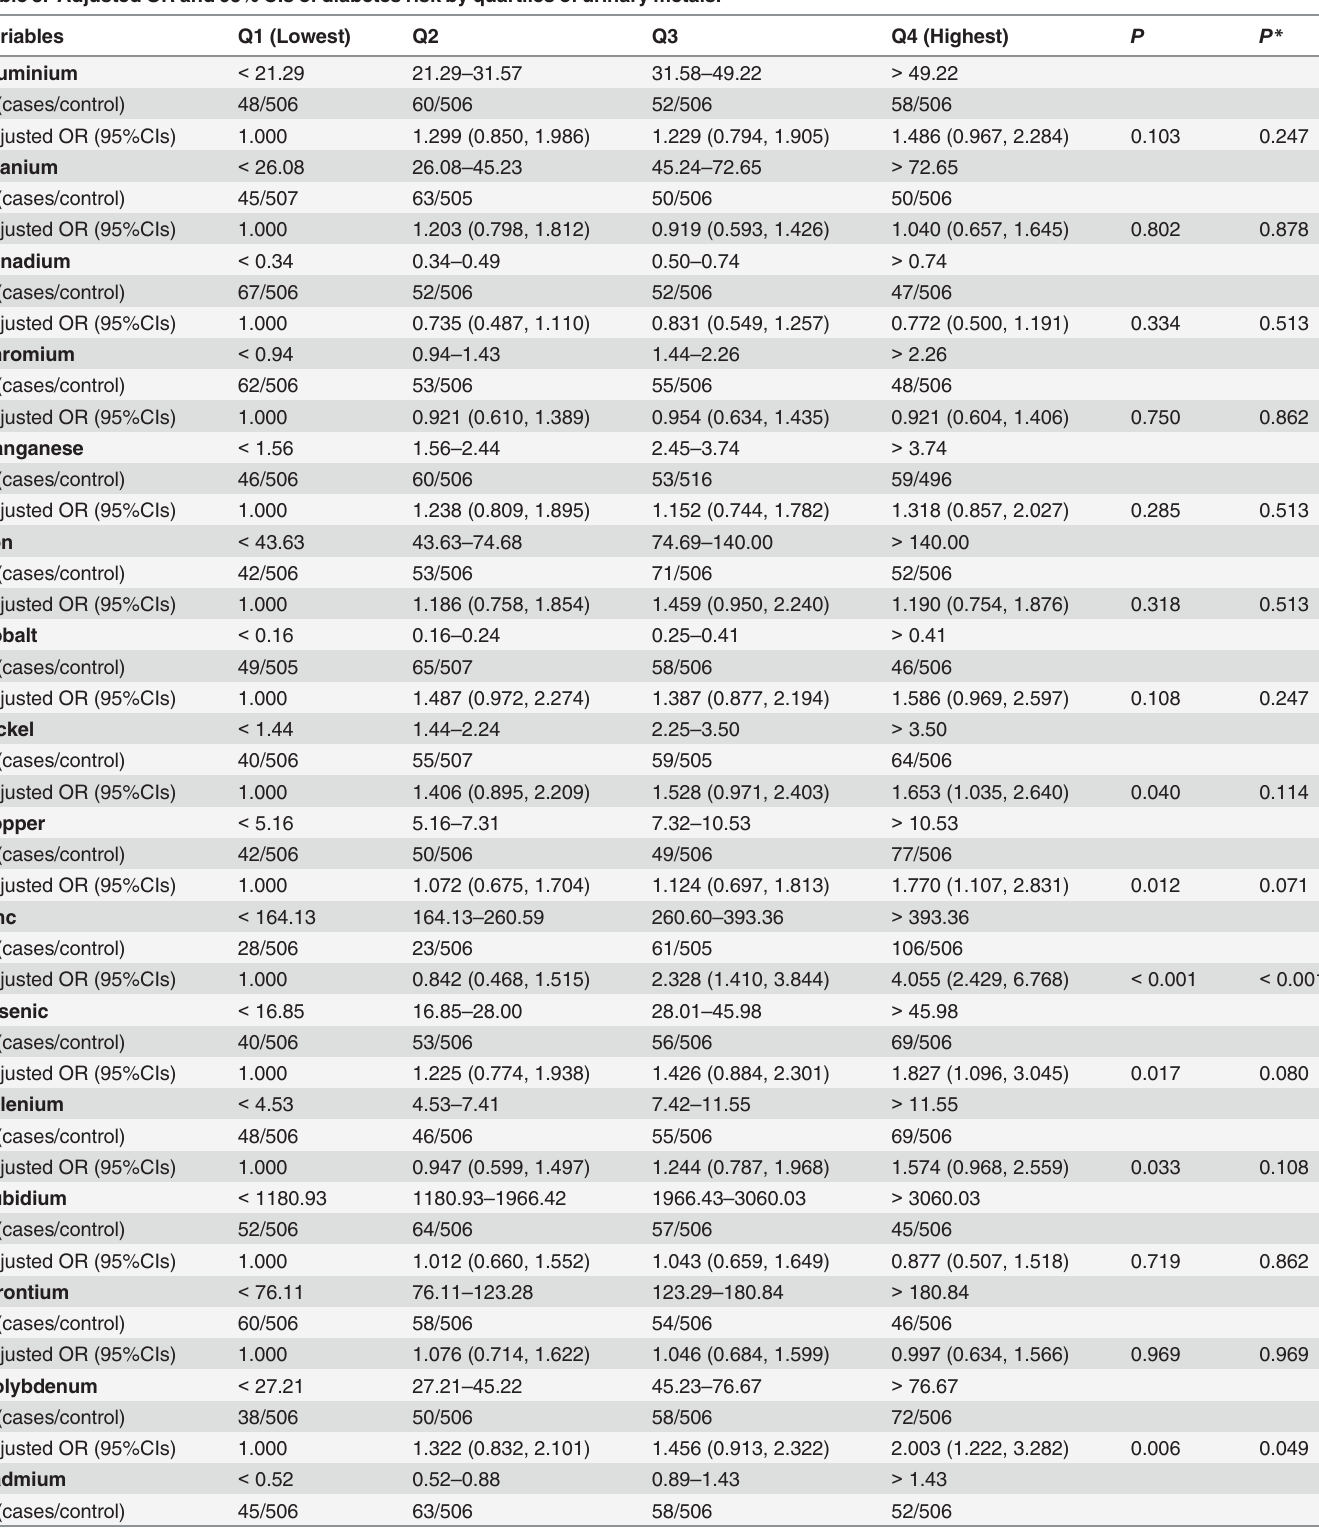
Table 3. Adjusted OR and 95% CIs of diabetes risk by quartiles of urinary